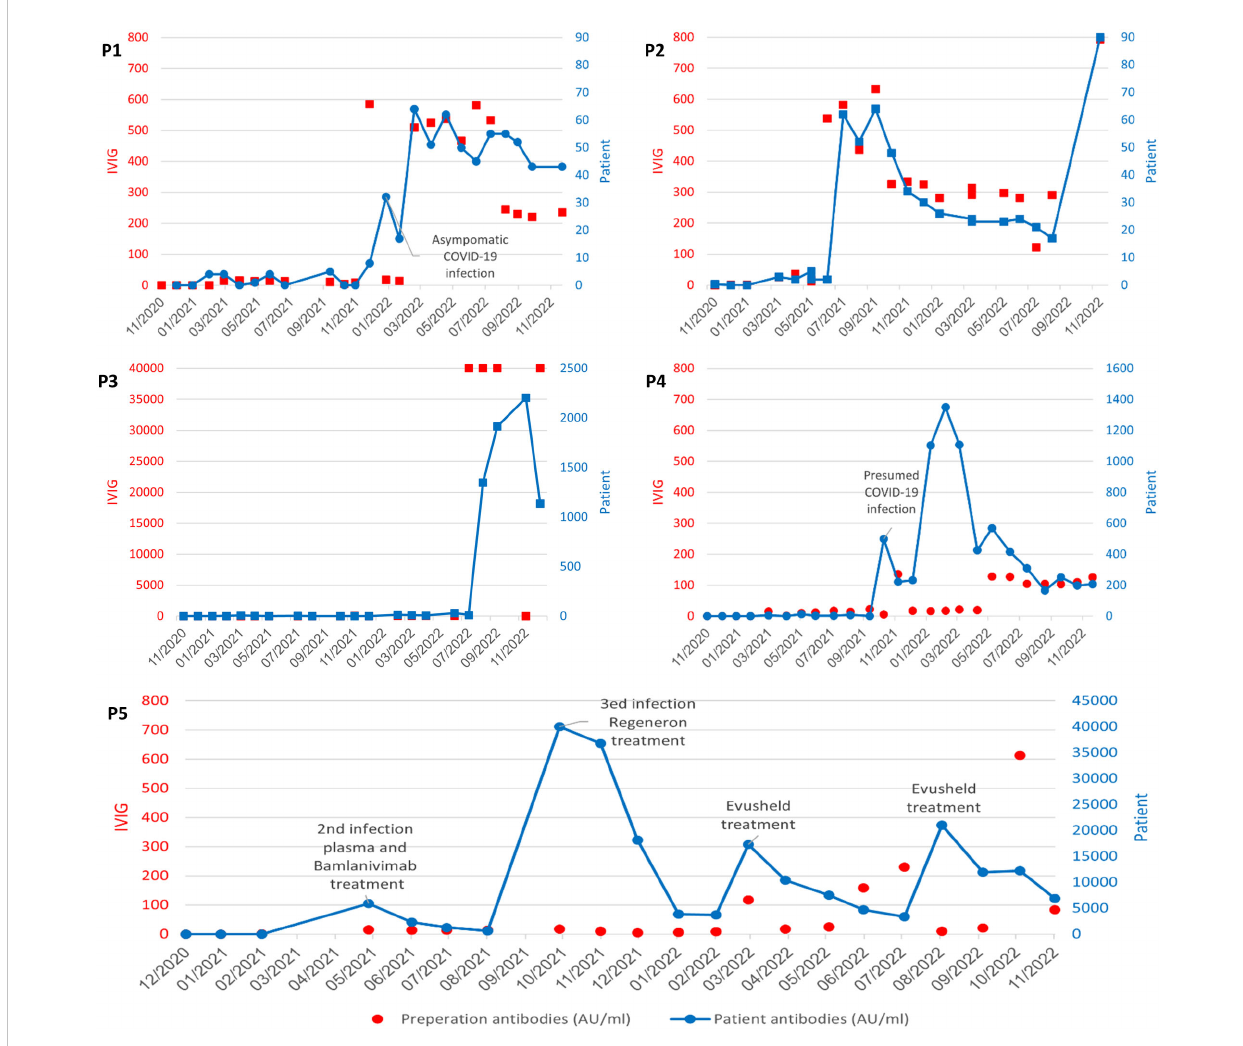
FIGURE 1 Titer levels reported in AU/mL in commercial IVIG products and patient serum A-P1; B- P2; C-P3; D- P4; E-P5. SARS-CoV2 antibody levels in IVIG preparations (left y axis, red) with re fl ected patient serum SARS-CoV2 antibody levels over time (right y axis, blue). P1, P2 and P3 treated with high and low titer SARS-CoV2 IVIG (red)with re fl ective rise and fall in mean patient SARS-CoV2 antibody levels (blue) over time. P4: Detection of SARS- CoV2 antibody levels (499AU/mL) in P4 noted prior to receiving SARS-CoV2 IVIG suggestive of asymptomatic infection. This was followed by low titer SARS-CoV2 IVIG and lower patient serum titers. P5: high titer patient SARS-CoV2 antibody levels re fl ective of treatment with Bamlanivimab, Casirivimab/imdevimab (Regeneron) and Tixagevimab/cilgavimab